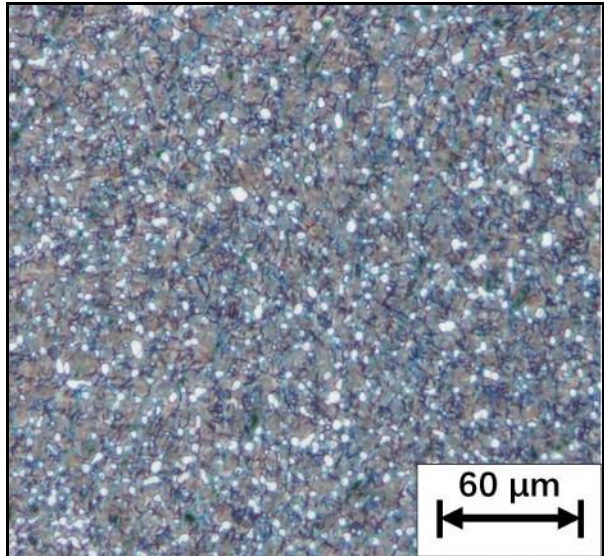
Figure 1. Initial microstructure of the material.